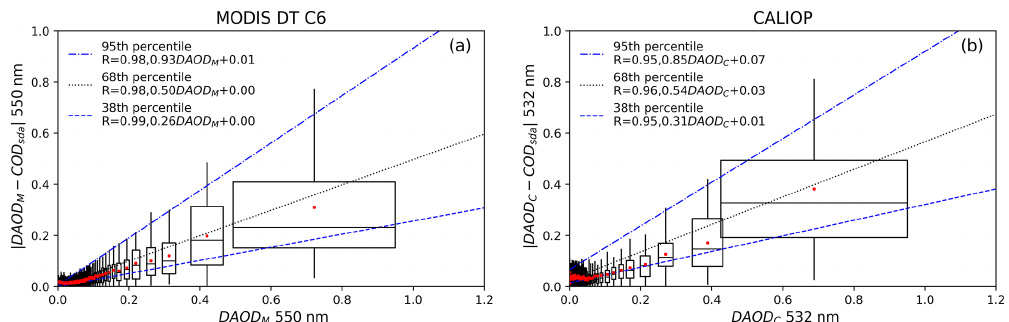
based on CALIOP. The global annual mean DAOD (TAOD) is 0.032 (0.121) and 0.067 (0.171) according to CALIOP and MODIS retrievals,